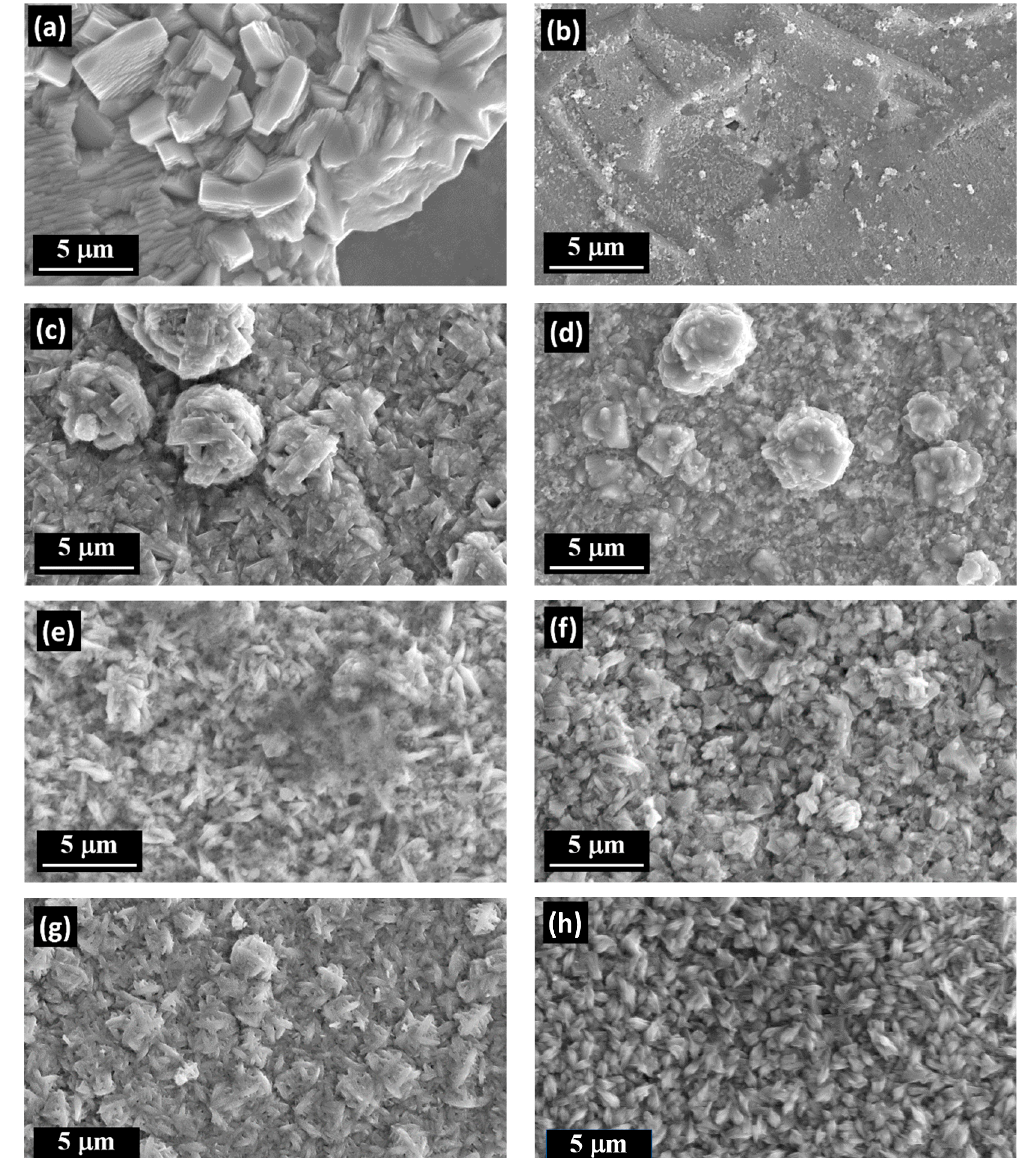
Figure 8. SEM secondary electrons (SE) images of surfaces of Zn ( a ) and Zn–SiC ( b – h ) layers formed by DCD at − 3.0 A·dm − 2 , with ( c – h ) or without ( a , b ) surfactants. ( c ) SDS, ( d ) gum arabic, ( e ) gelatin, ( f ) CTAB, ( g ) PEG 20000, ( h ) Triton X–100.